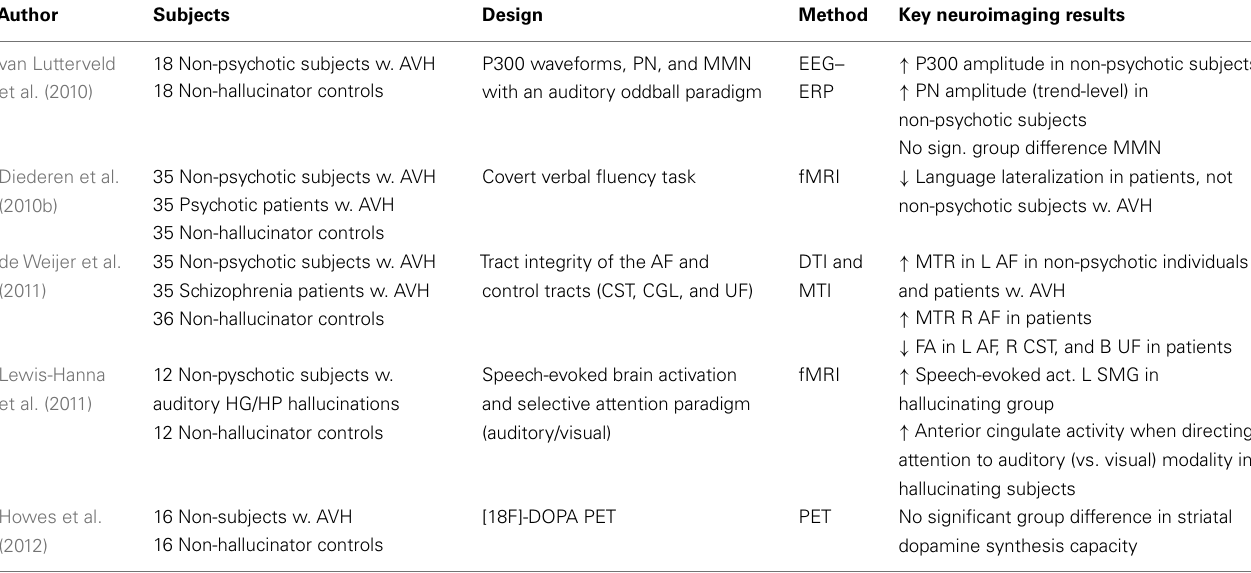
Table 2 |Trait studies onAVH in non-psychotic